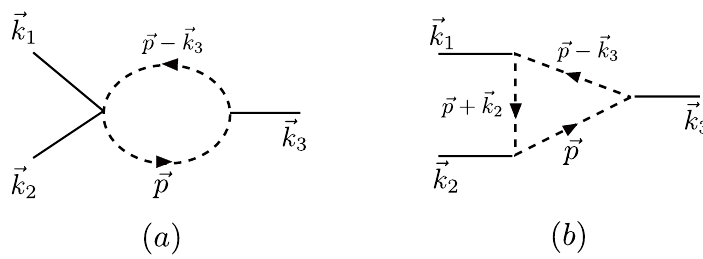
Figure 5. Loop-level contribution to the bispectrum from m 2 ˜ χ 2 -type symmetry breaking. The solid lines correspond to inflaton propagators, while dashed lines to complex scalar